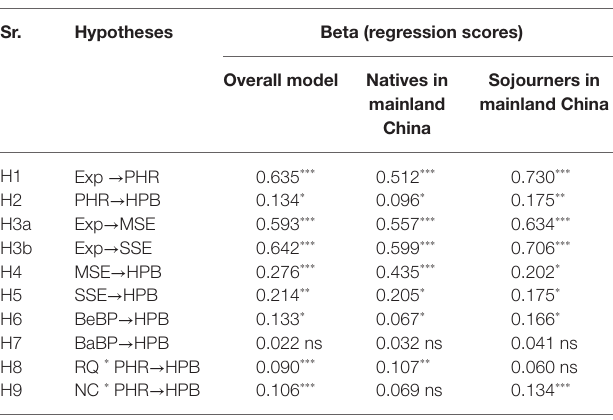
TABLE 4 | Path analysis for overall model and subgroups (sojourners vs. natives).